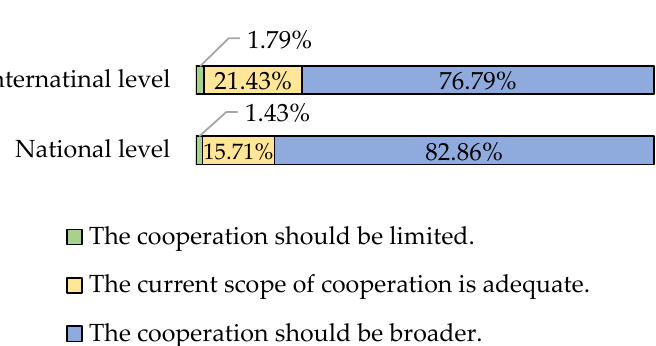
Figure 5. The attitude of ERIH sites to cooperation on the national and international level.